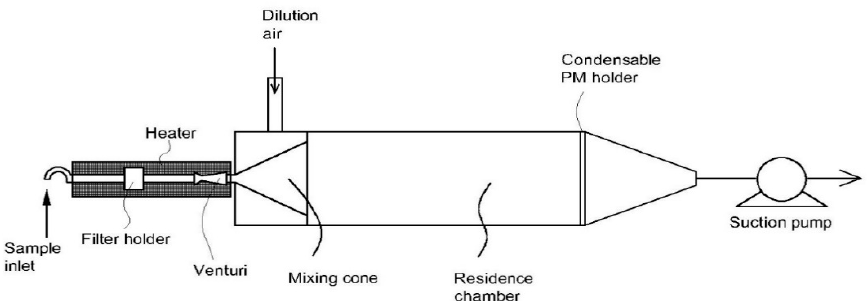
Figure 14. General schematic diagram of a dilution system for measuring condensable particulate matter [117].